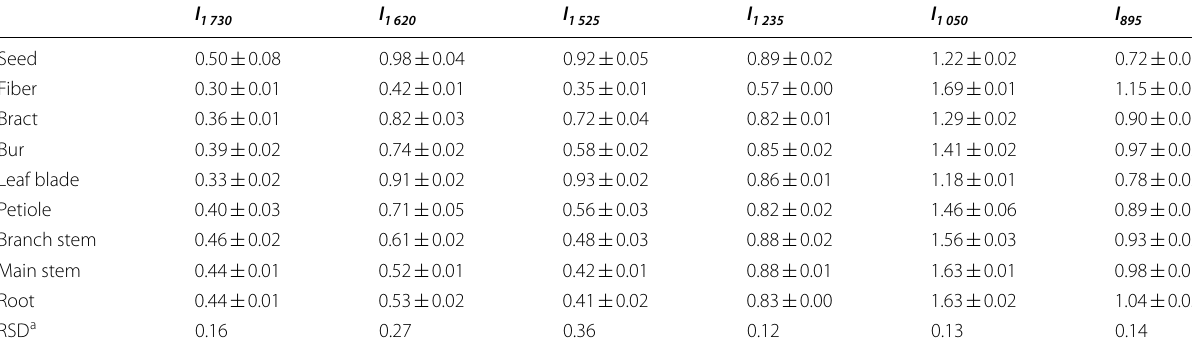
Table 2 The normalized intensities of six ATR FT-IR bands of the plant biomass from the fiber maturity stage. Data are present as average standard deviation (n 4) ± =